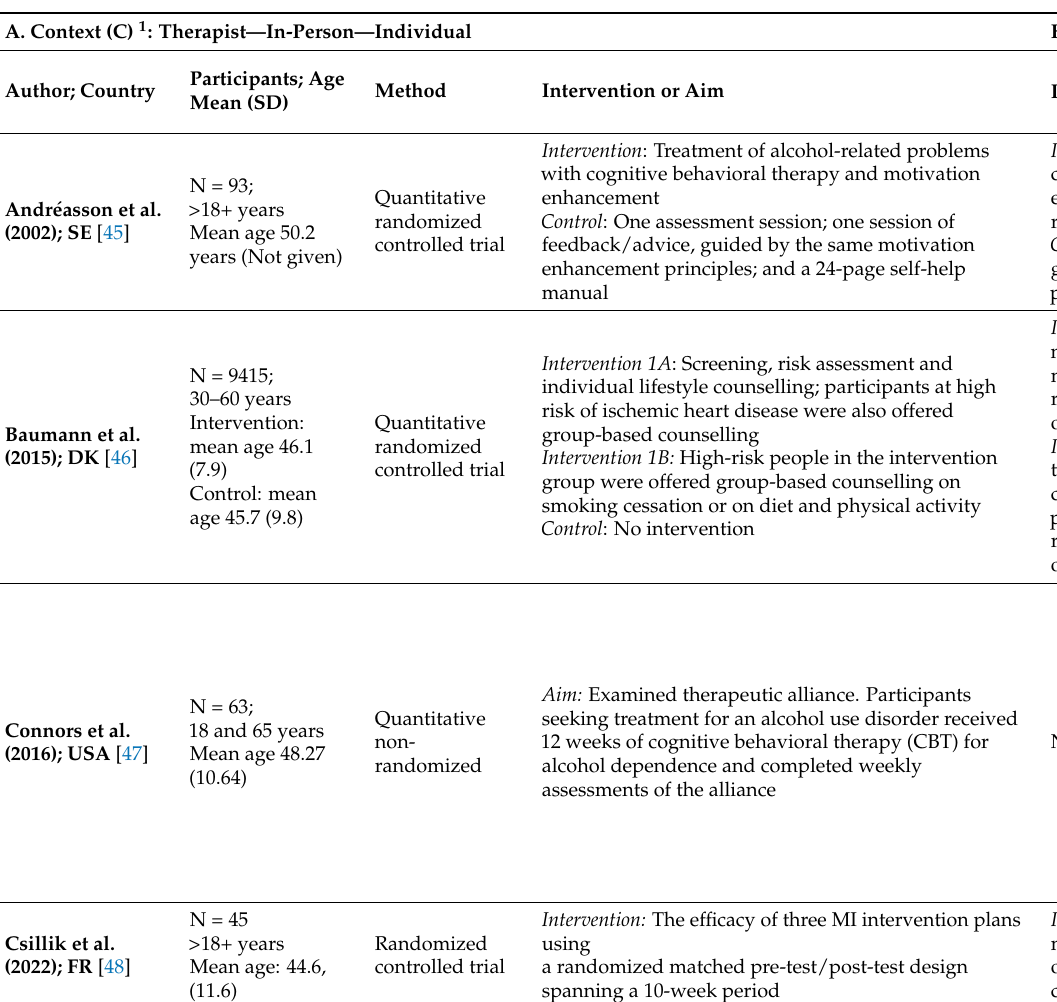
Table 4. Characteristics of the